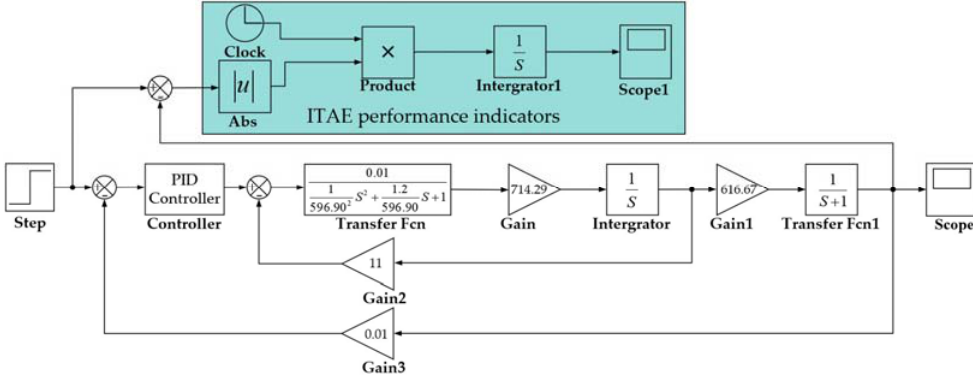
Figure 6. Simulation model of PMSS.